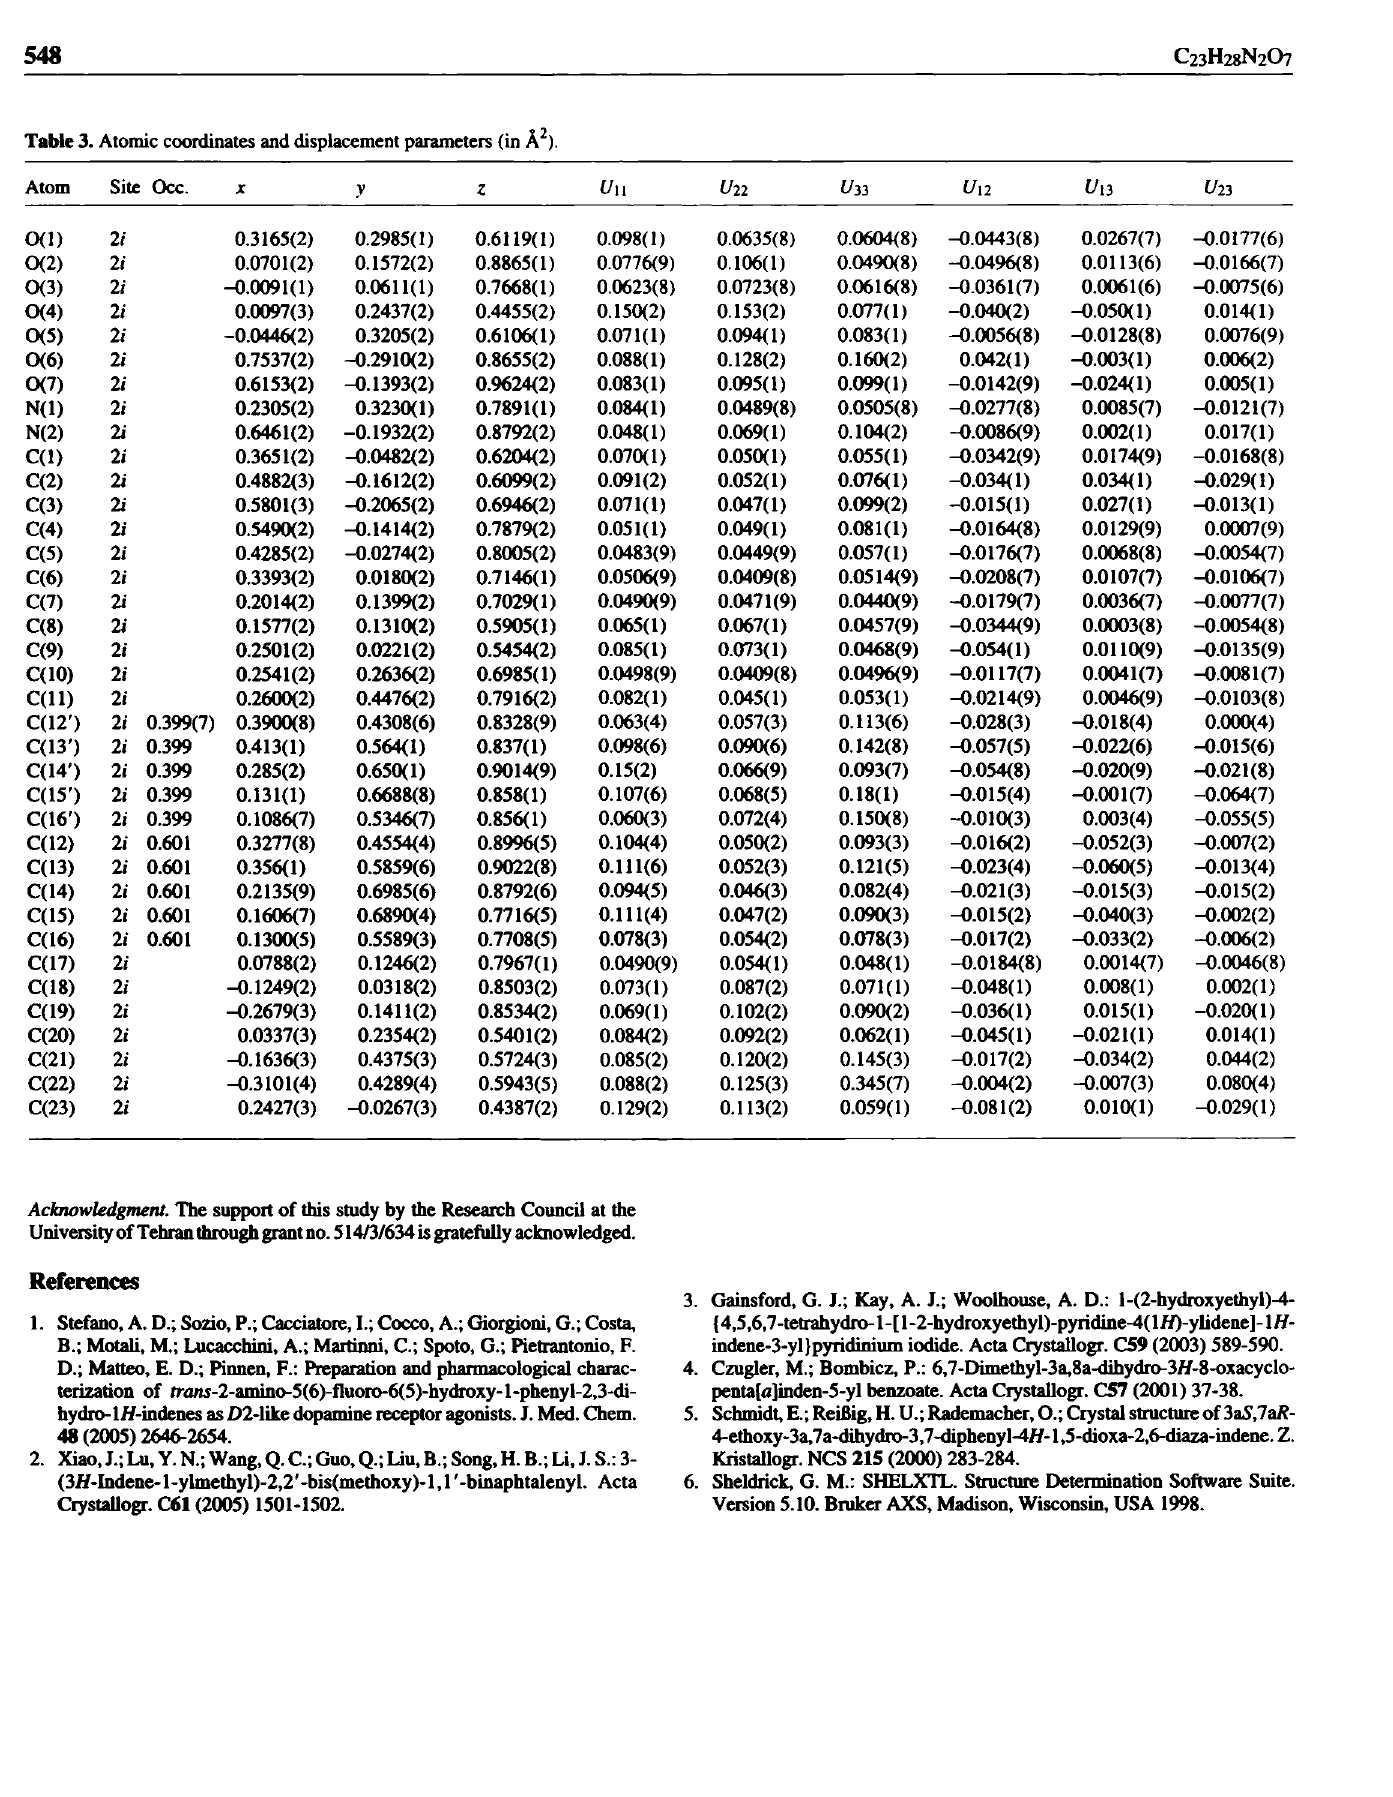
Table 3. Atomic coordinates and displacement parameters (in Ä 2